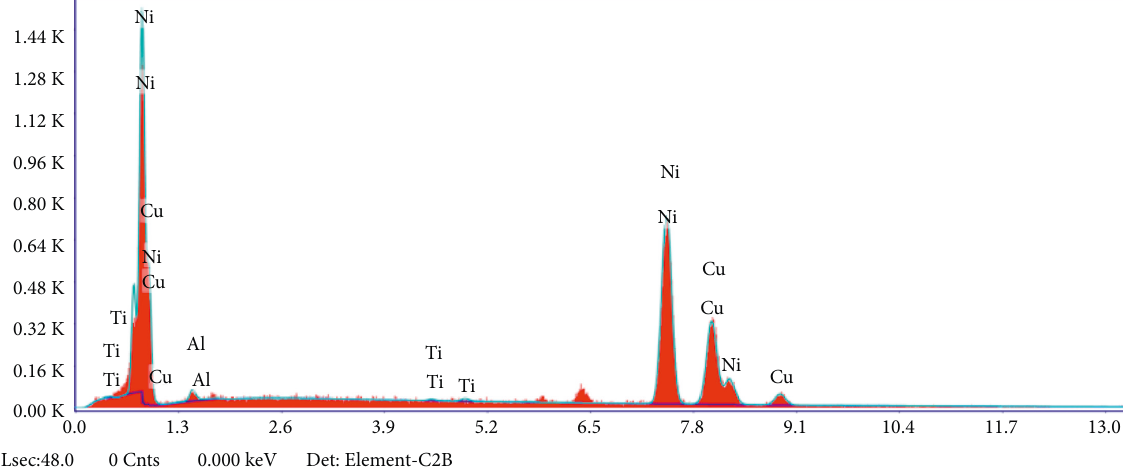
Figure 6: EDX spectrum of Ni-alloy composites (Ni-alloy/TiO